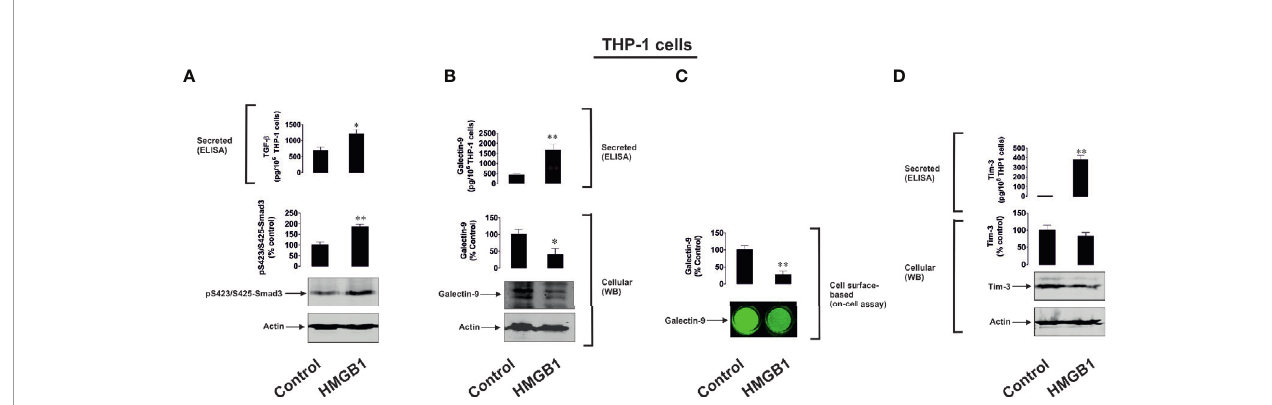
FIGURE 1 | HMGB1 induces TGF- b dependent expression of galectin-9 in THP-1 human AML cells. THP1 cells were exposed for 24 h to 1 µg/ml HMGB1 followed by measurement of TGF- b secretion and Smad3 activating phosphorylation (A), galectin-9 protein expression and secretion (B) , galectin-9 cell surface presence (C) and Tim-3 protein expression and release (D) . Images are from one experiment representative of 4 giving similar results. Quantitative data are shown as mean values ± SEM from 4 independent experiments. *p < 0.05 and **p < 0.01 vs